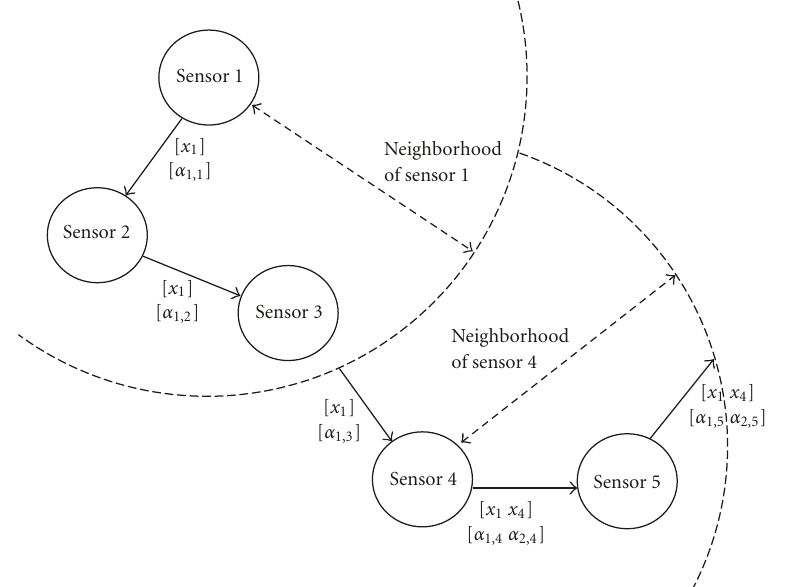
Figure 2: Illustration of the distributed learning algorithm.